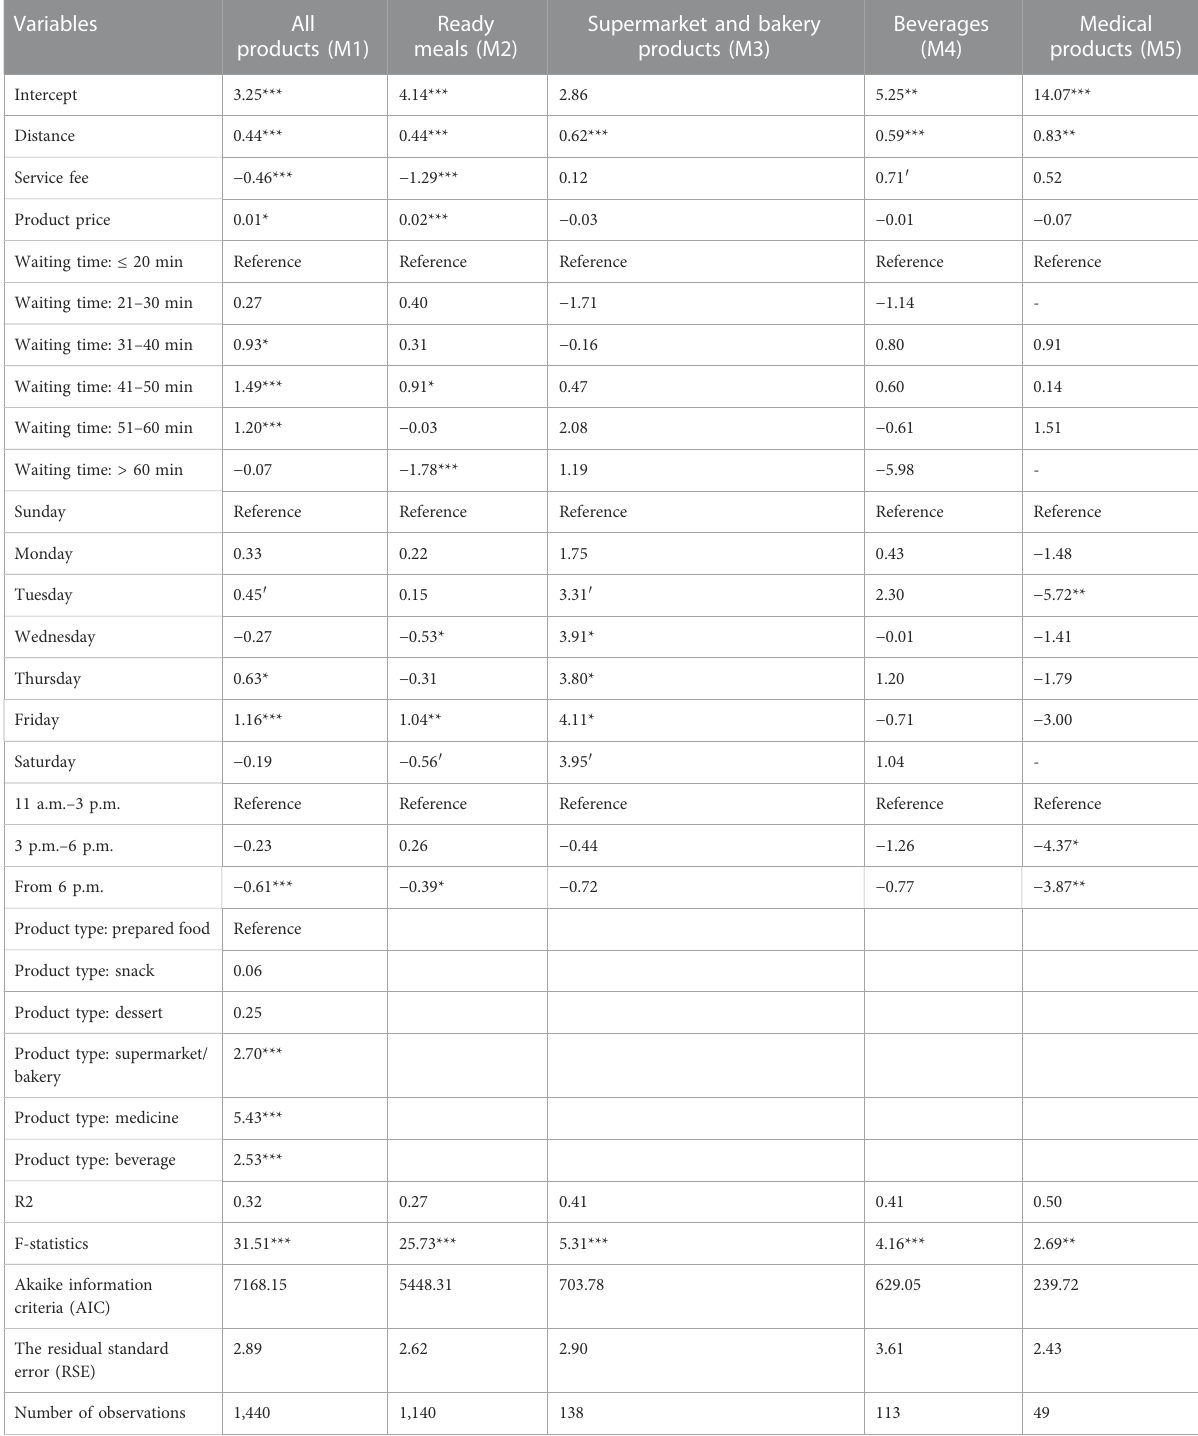
TABLE 2 Estimated coef fi cients of the